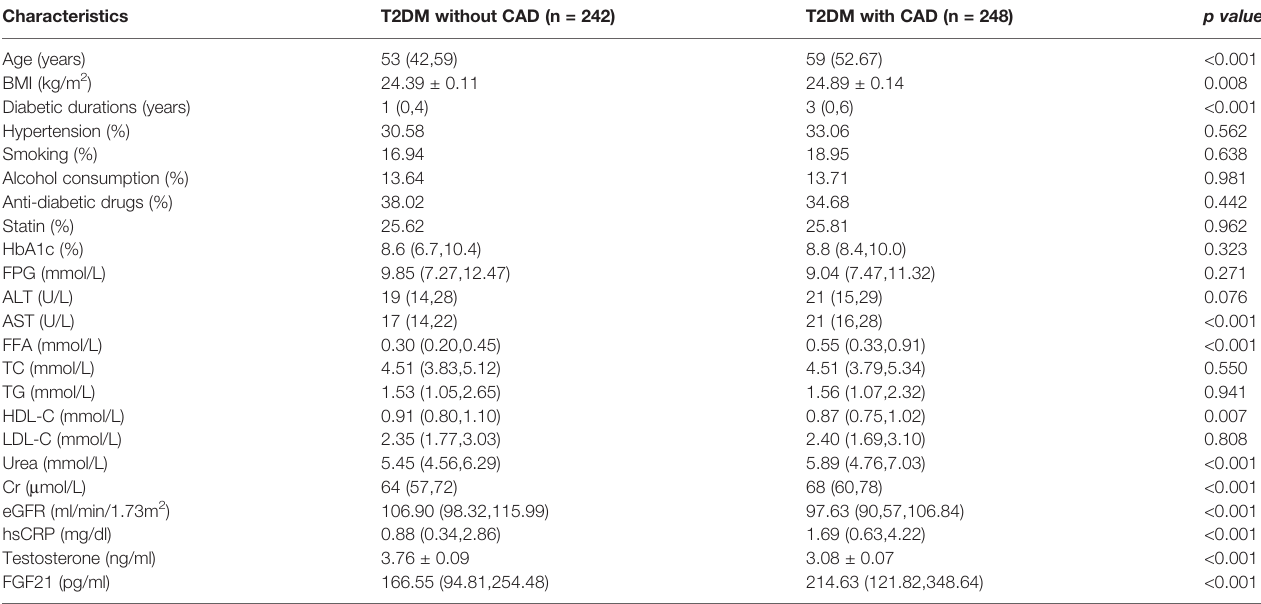
TABLE 1 | Clinical and Biochemistry characteristics of all subjects.